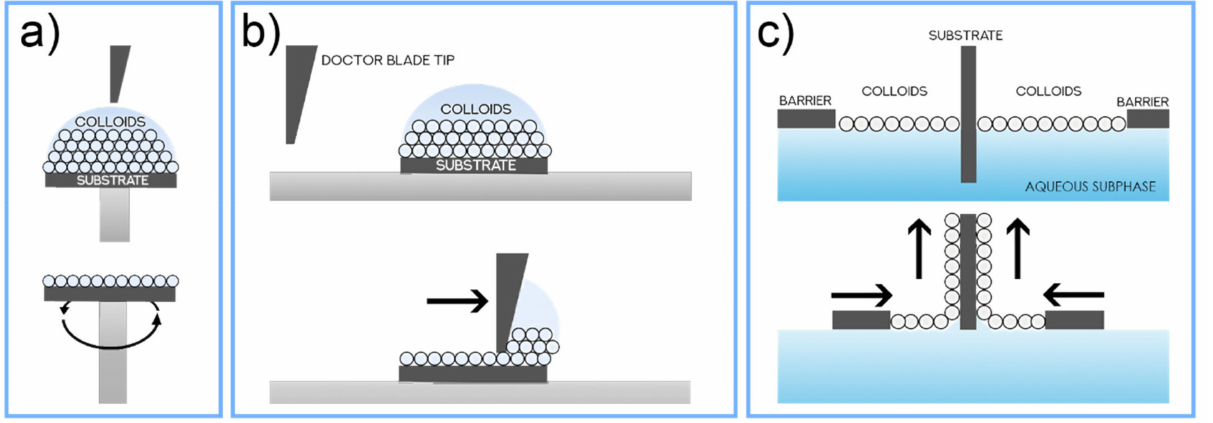
Figure 4. Production of a colloidal monolayer using ( a ) a spin-coating technique, ( b ) doctor blade trough, ( c ), and a Langmuir–Blodgett